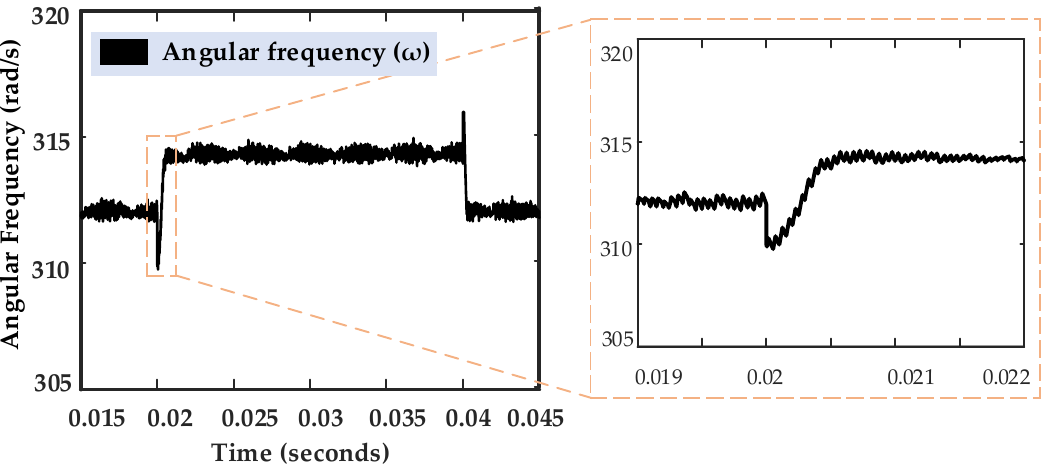
Figure 10. Simulation results. ( a ) Active power response without proposed control scheme. ( b ) Re- Distributed secondary control strategy is used to regulate the system frequency. In active power response without proposed control scheme. ( c ) Proportional active power sharing pro- Figure 11, it is noticed that activation of the proposed strategy at time 0.02 s, yields posed control scheme. ( d ) Proportional reactive power sharing with proposed control scheme. ( e ) frequency restoration within an acceptable range of ± 0.5 Hz. Load buses V bus1 , V bus2 and V bus3 response curve. ( f ) Average load bus voltage curve of V bus1 , V bus2 and V bus3 ( g ) V bus1 and V bus3 voltage curve by weight (ω b1 , ω b2 ) variation from 1 to 300.